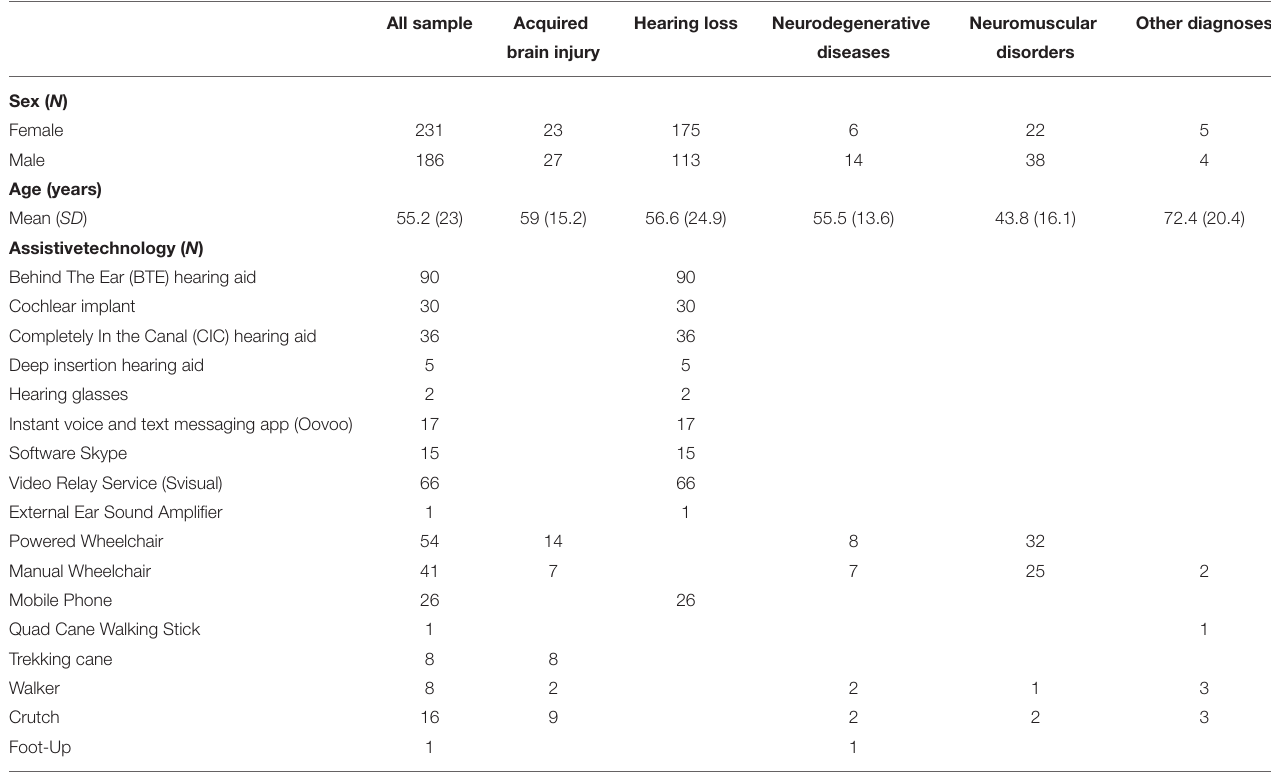
TABLE 1 | Socio-demographic characteristics of the sample by the type of disability.